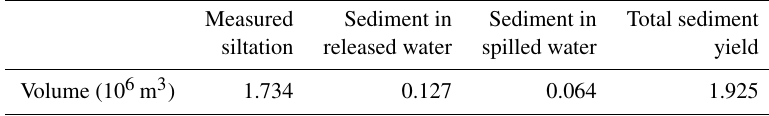
Table 3. Results of sediment transport in Ghézala dam during 1985–2011.